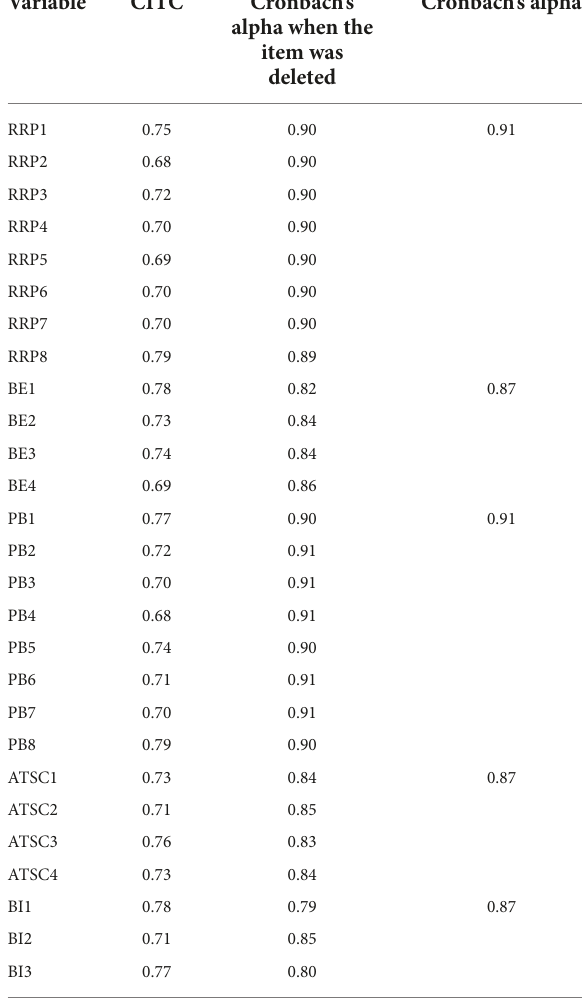
TABLE 3 Reliability analysis results for each study variable.